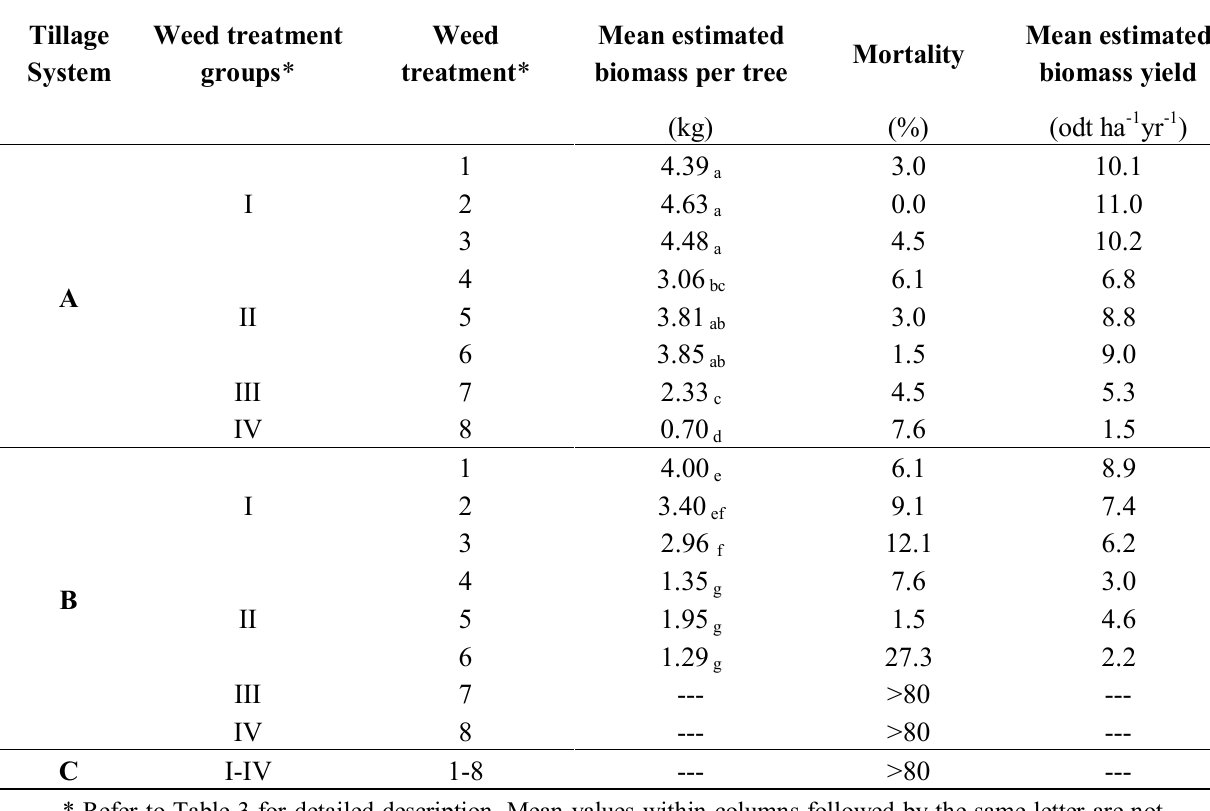
* Refer to Table 3 for detailed description. Mean values within columns followed by the same letter are not significantly different according to Tukey HSD test (sig level p < 0.05, p -values: a = 0.62, b = 0.80, c = 0.14, d = 1.00, e = 0.22, f = 0.62, g =